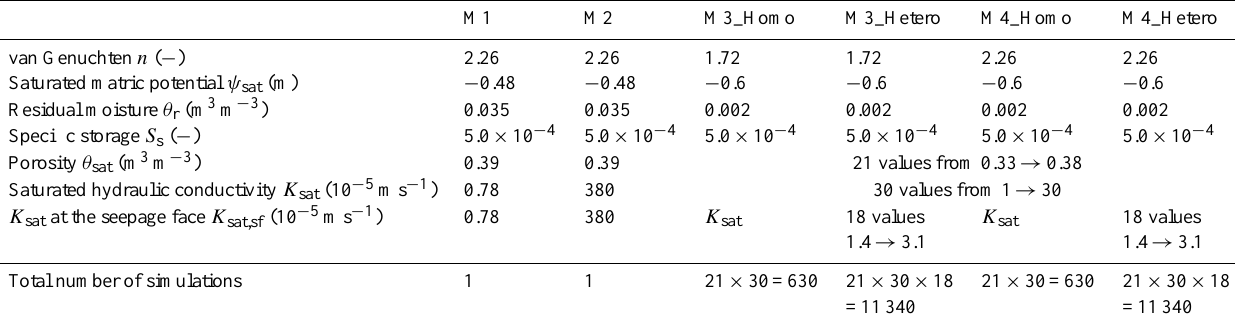
Table 1. Model scenarios and associated parameter